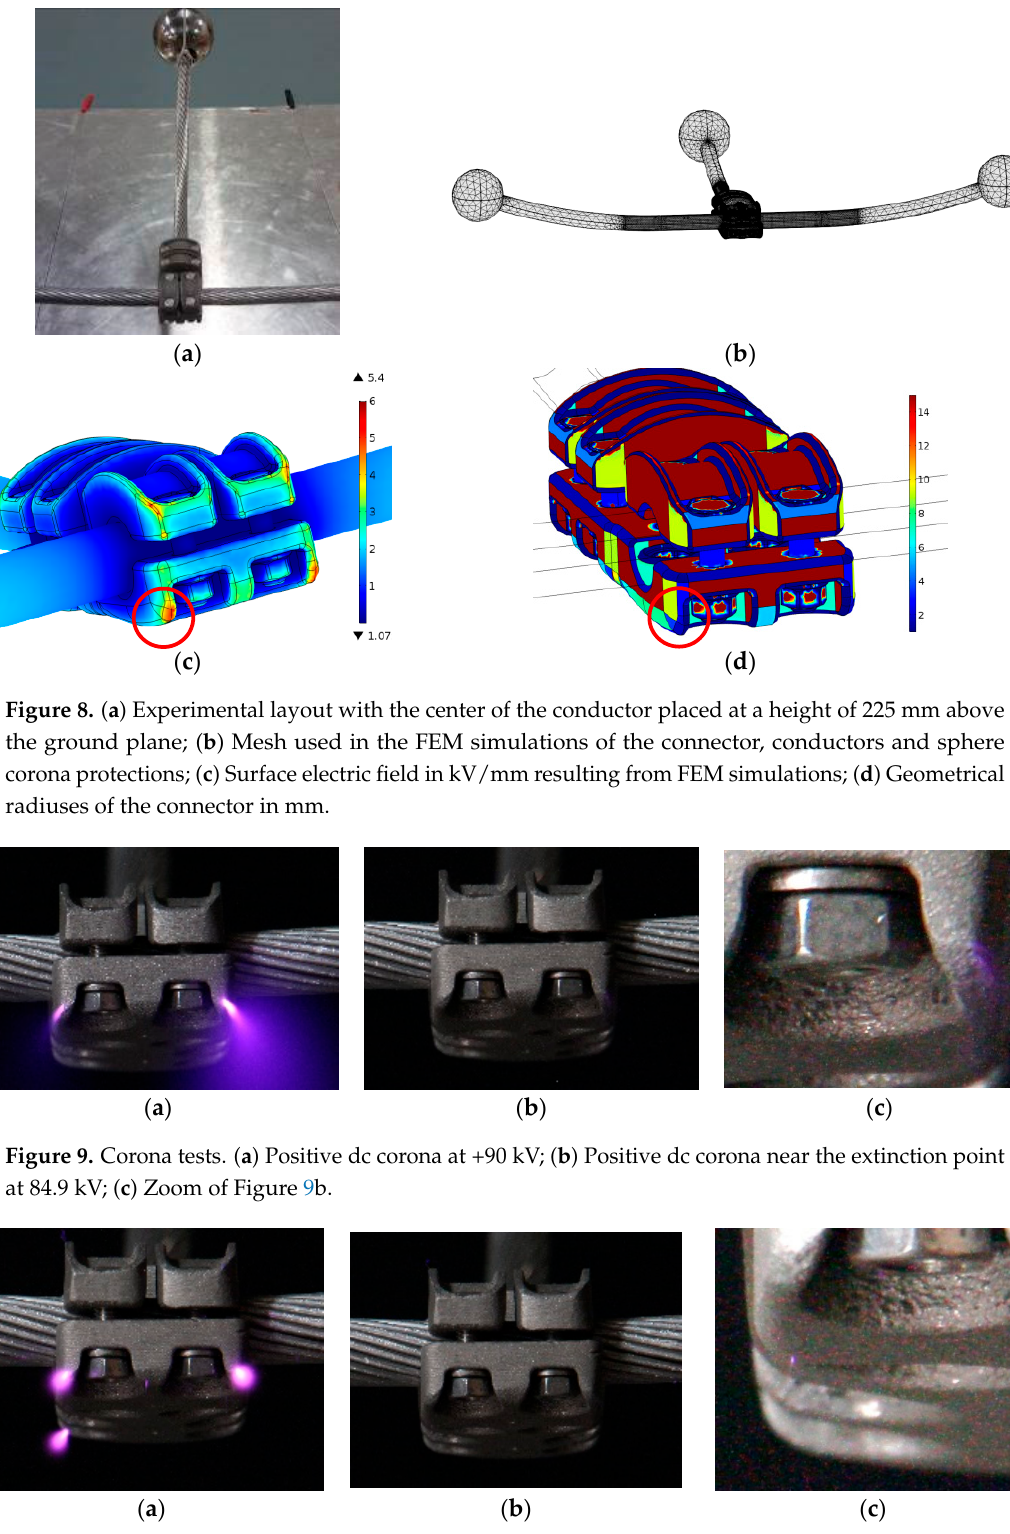
Figure 10. ( a ) Negative dc corona at − 100 kV; ( b ) Negative dc corona near the extinction point at − 77